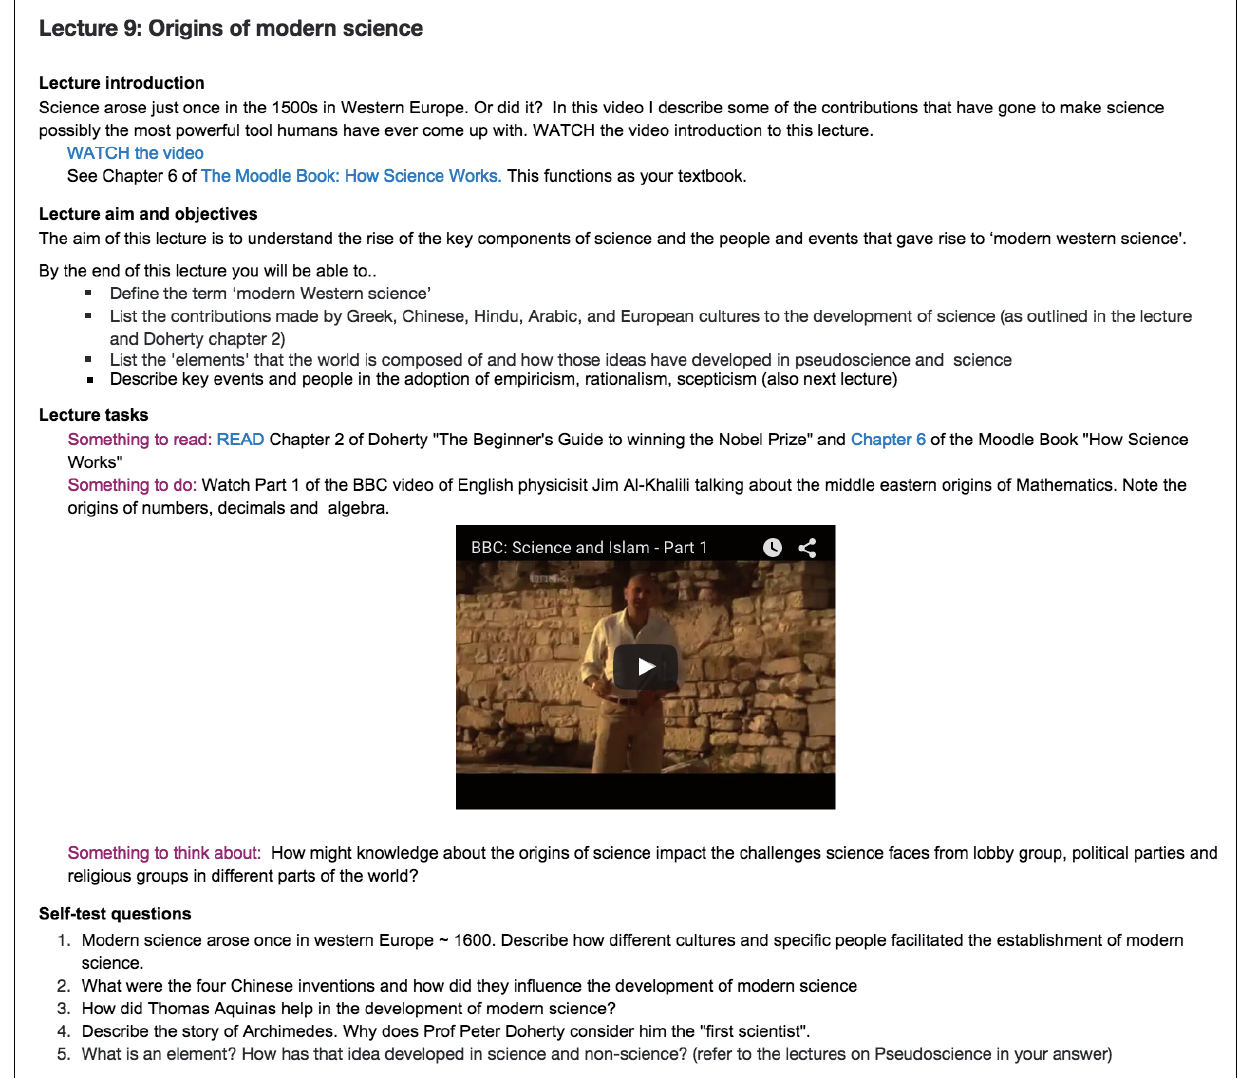
Figure 6. Example of a web page that accompanies one of the lectures. The same structure every week to create expectations of learning activity. The students are directed to the video BBC: Science and Islam - Part 1 in “Something to Do”.